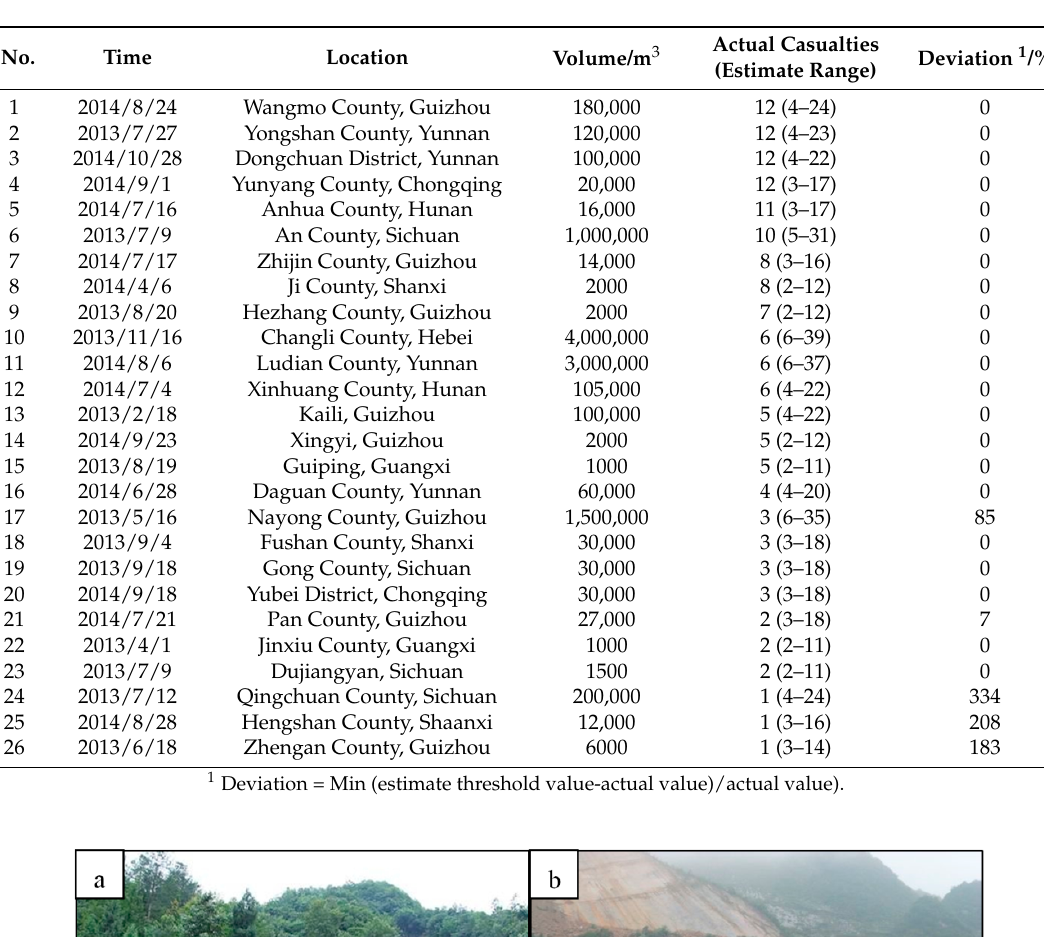
Table 5. Validation of the threshold value curve of landslide casualties.